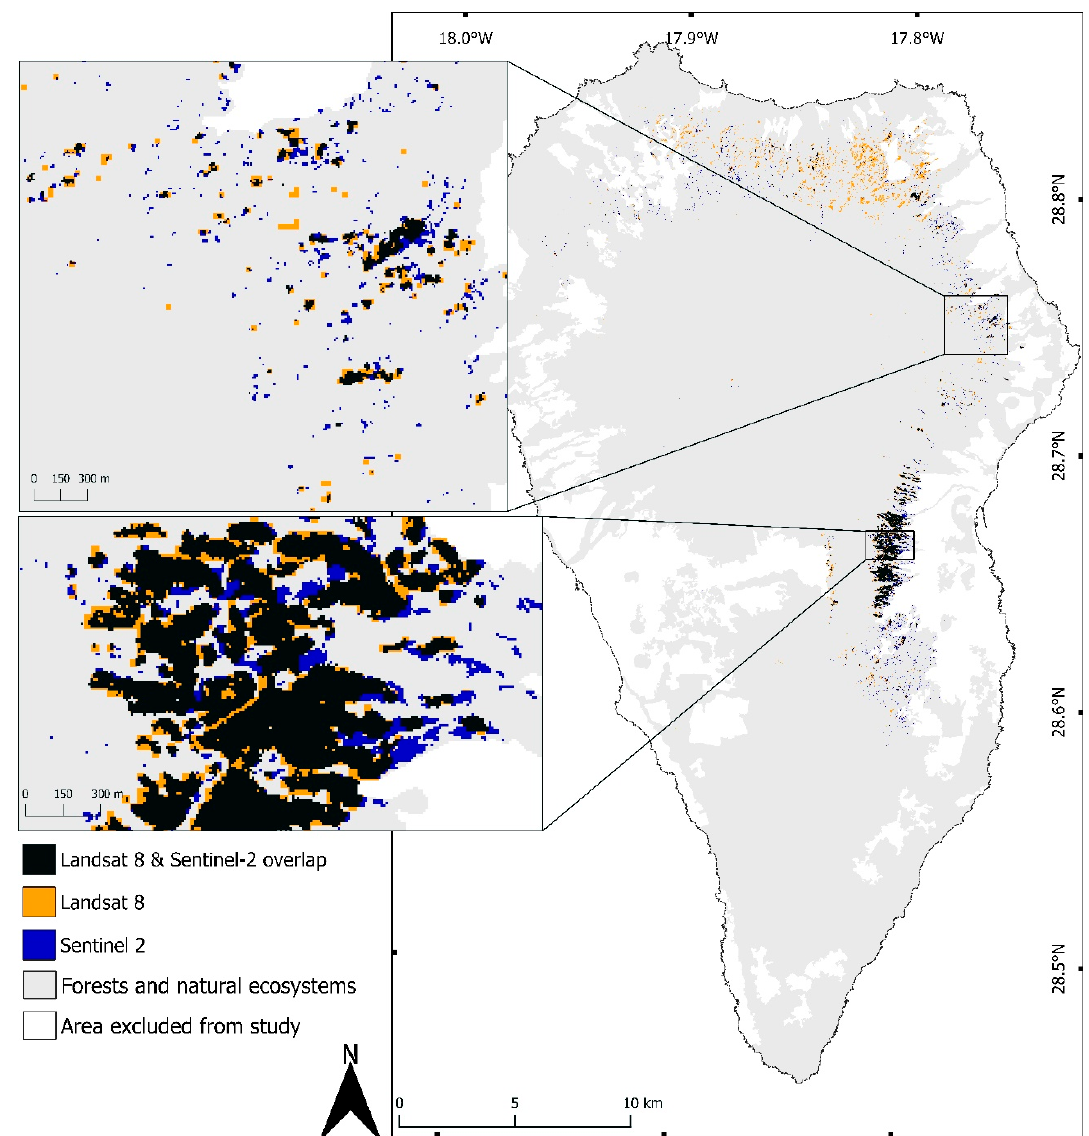
Figure 5. C. sativa spatial coverage in the images from the Landsat 8 and Sentinel-2 overlapping, Landsat 8 only, and Sentinel-2 only. Black are pixels where C. sativa was detected in both sensors’ images; orange are pixels where C. sativa was only detected in the Landsat 8 image; blue are pixels where C. sativa was only detected in the Sentinel -2 image. The spatial resolution of Landsat 8 is 30 m, and Sentinel-2 is 10 m. ‘Forests and natural ecosystems’ (grey shading) are areas not directly used for human purposes. Human settlements, infrastructure, and agriculture (white) were cropped out. Spatial coverage of C. sativa increases progressively from 400 m a.s.l. to 700 m a.s.l. and decreases above 700 m a.s.l. in the images from both the sensors (Figure 6).